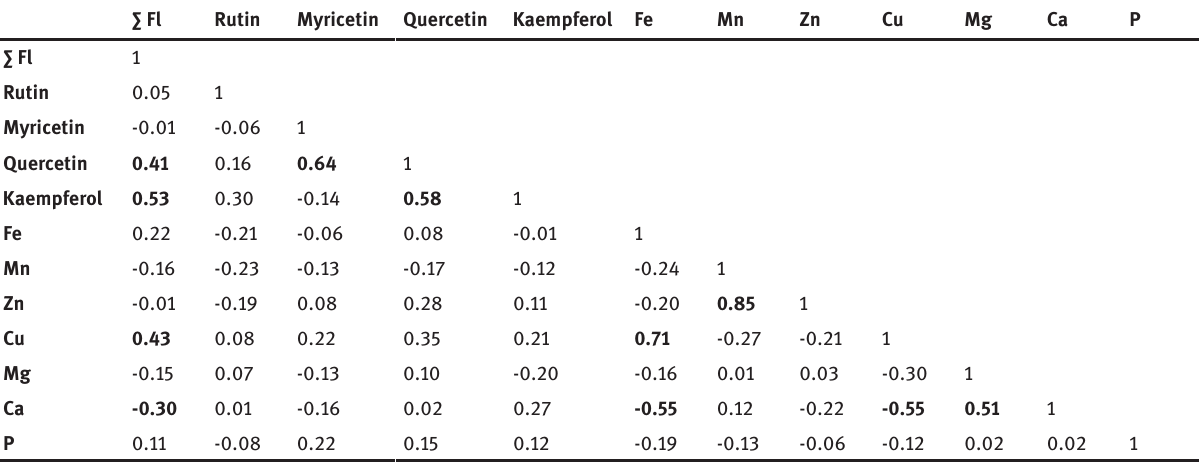
Table 2: The results of correlation analysis. The statistically significant (α < 0.05) correlation coefficients are printed in bold font. ∑